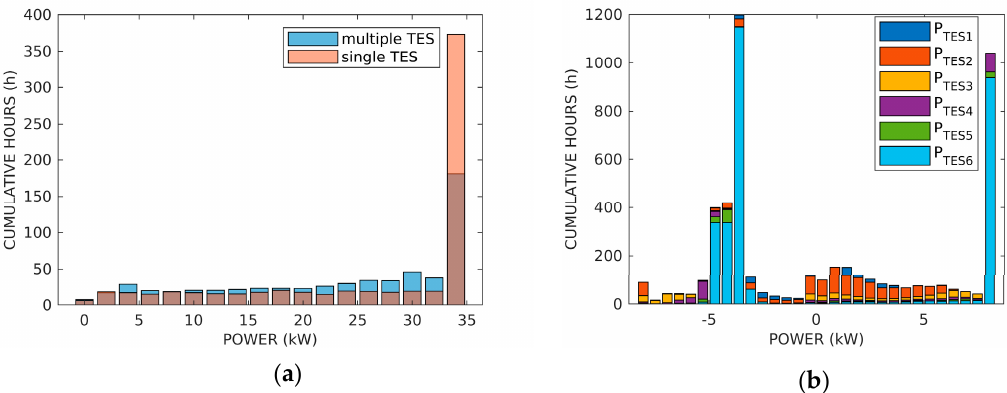
Figure 11. ( a ) Cumulative hours of LFR defocusing in the multiple and single LHTES yearly simulation; ( b ) cumulative hours of power exchanged by each module.